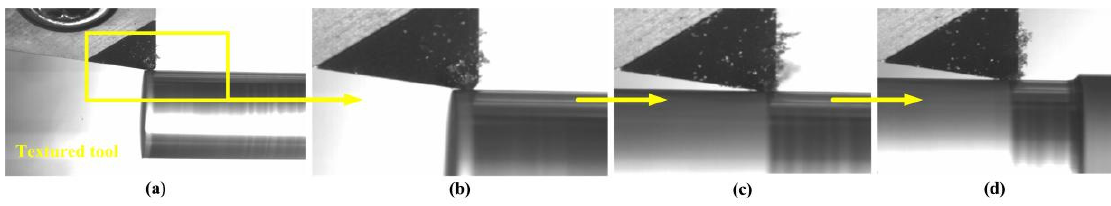
Figure 16. The SEM images of ( a ) non-textured PCD tool and ( b ) textured tool after 10 turnings.